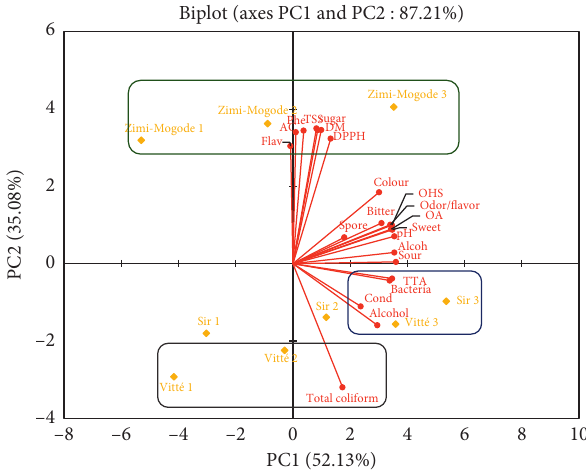
Figure 3: Loadings and scores biplot derived from principal component analysis (PCA) after varimax rotation and Kaiser normalization ( p < 0 . 001) using most of the measured